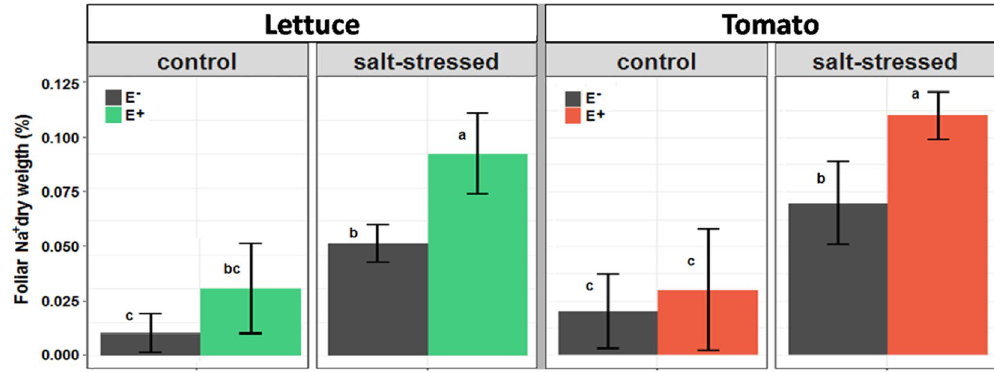
Figure 4. Foliar Na + content of lettuce (left) and tomato plants (right) grown for 90 (lettuce) or 100 days (tomato) under 50 mM NaCl (control) and 150 mM NaCl (salt-stressed) in the presence ( + E) or absence ( − E) of root fungal endophytes. Values are means ± SE (n = 20). Different lowercase letters indicate, for each species separately, significant differences between treatments (Tukey HSD tests; α = 0.05).